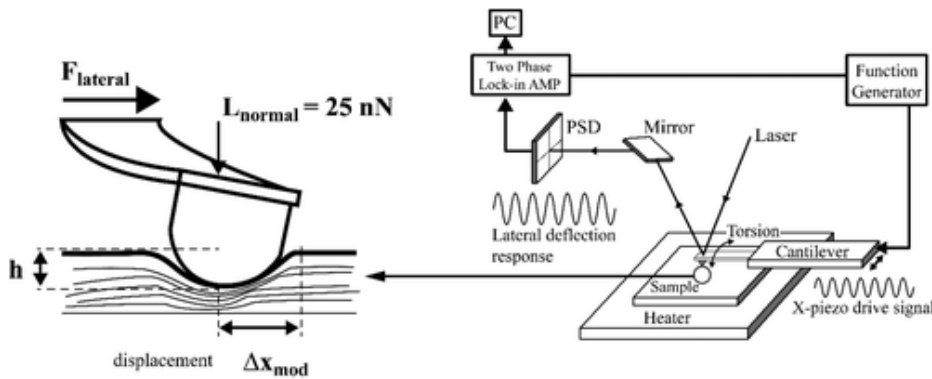
Figure 16. A schematic of shear modulation force microscopy. Reproduced from [29] with permission of the American Chemical Society.